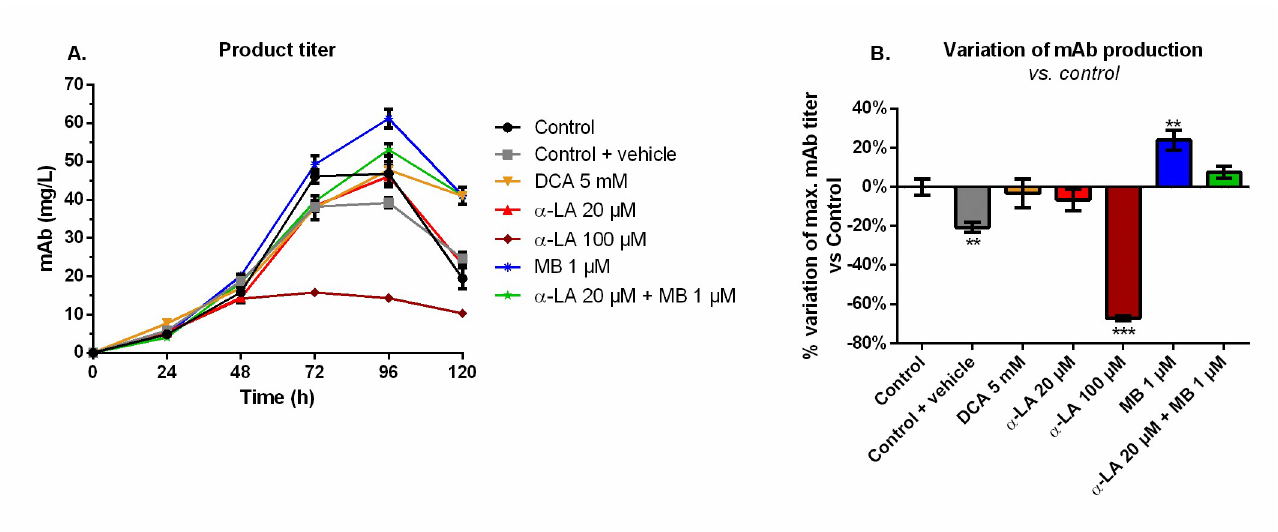
Fig 5. Monoclonal antibody (mAb) production and variation of the maximum mAb titer in the extracellular medium for the various drug treatments versus control. (A) Product titer was determined by ELISA and (B) its effect on mAb production is presented as the percentage of variation versus control.